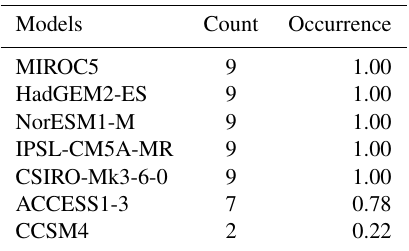
Table C8. Absolute and relative occurrence of each individual model included in the Antarctica top three combinations presented in Table